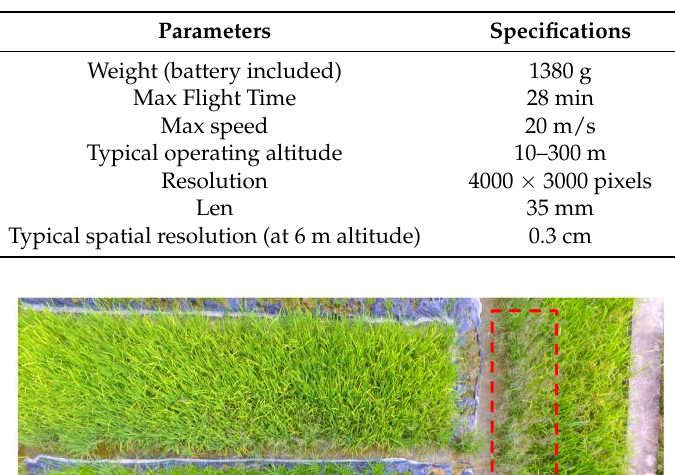
Table 1. Technical characteristics of the UAV platform.